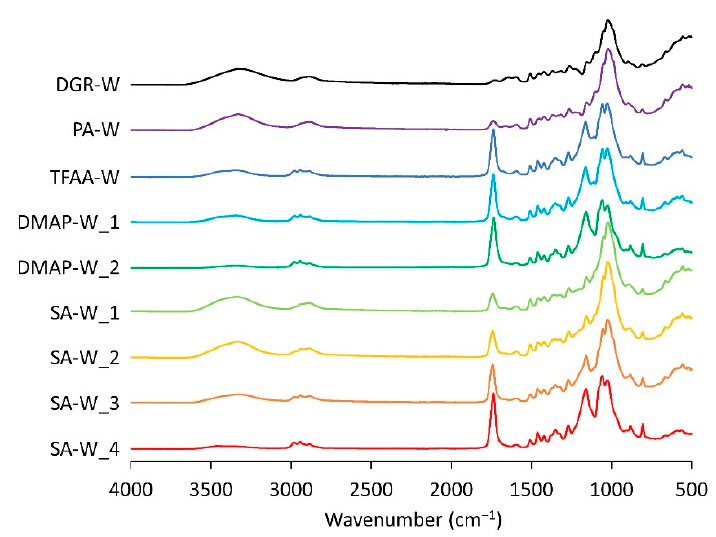
Figure 2. Fourier-transform infrared (FT-IR) spectra of degreased wood and propionylated woods.